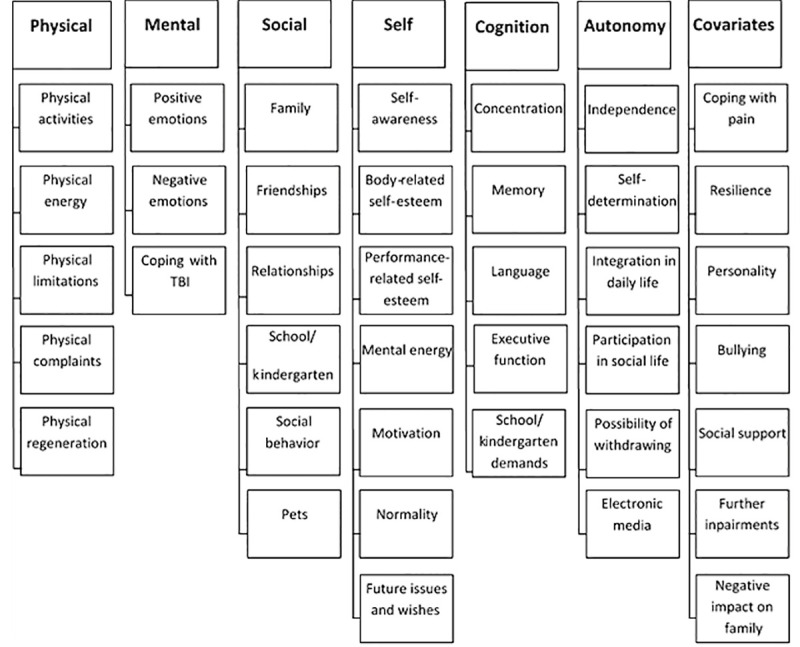
Category system.